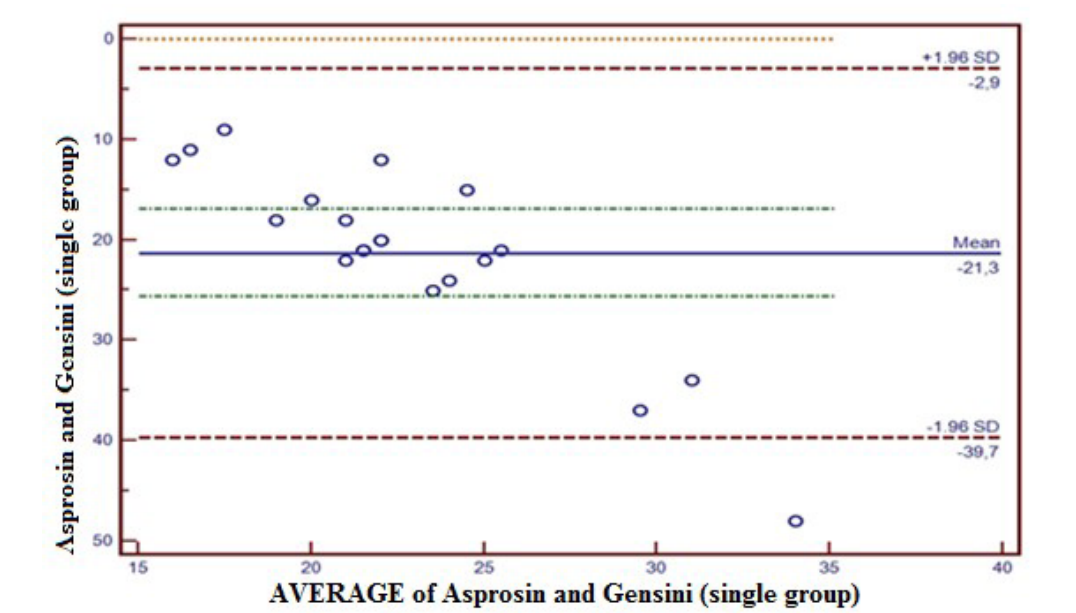
Fig. 3 - Concordance between Asprosin value and Gensini score in the single coronary lesion group. The concordance between Asprosin and Gensini by Bland-Altman method in the single coronary lesion group was -39.7 to 2.9 at a confidence level of 95%. Five percent (5%) of total observations was observed out of confidence level of 95%. SD=standard deviation